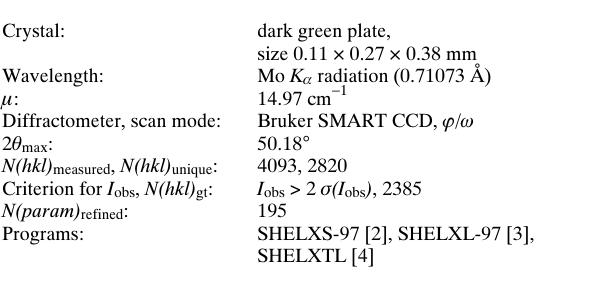
Table 1. Data collection and